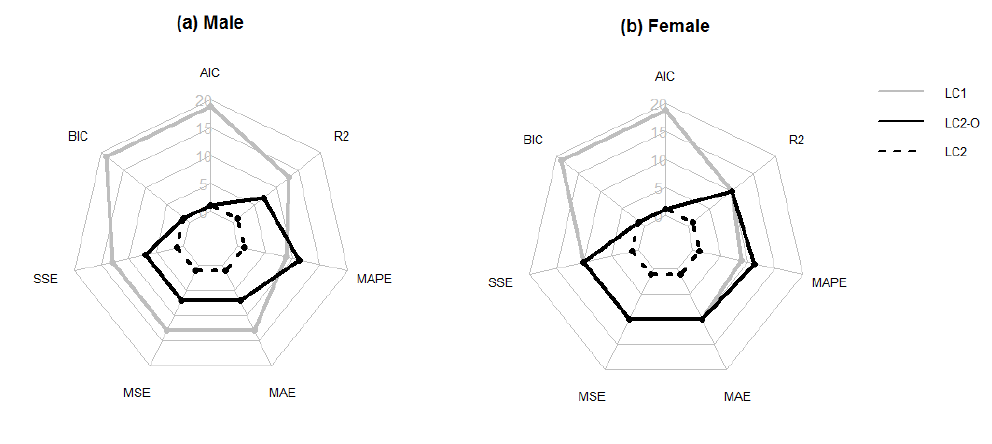
Figure 4. Radar graph summarizing the number of countries for which each model (LC, LC2, and LC2-O) achieves the best forecasting ability according to the repeated hold-out method for males ( a ) and females ( b